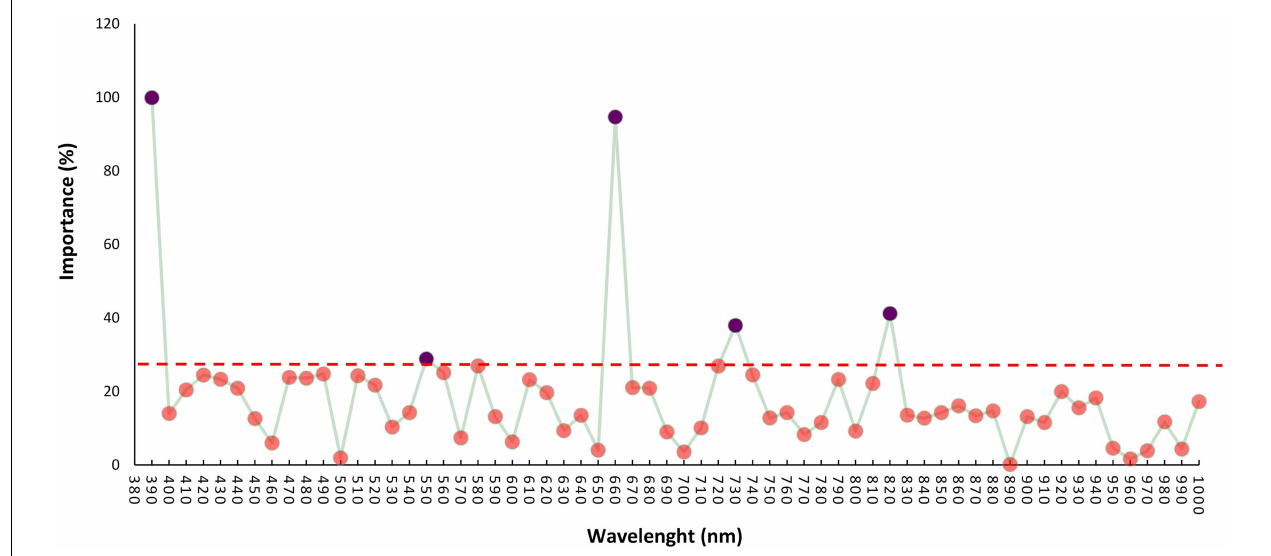
FIGURE 4 | Hyperspectral wide association analysis (HypWAS) of yield in the tested soybean panel. The threshold for significant importance values was indicated as the red dash line.